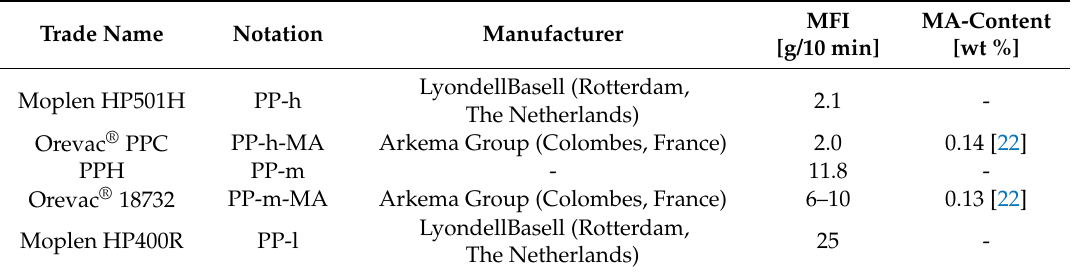
Table 1. Properties of the five polymer